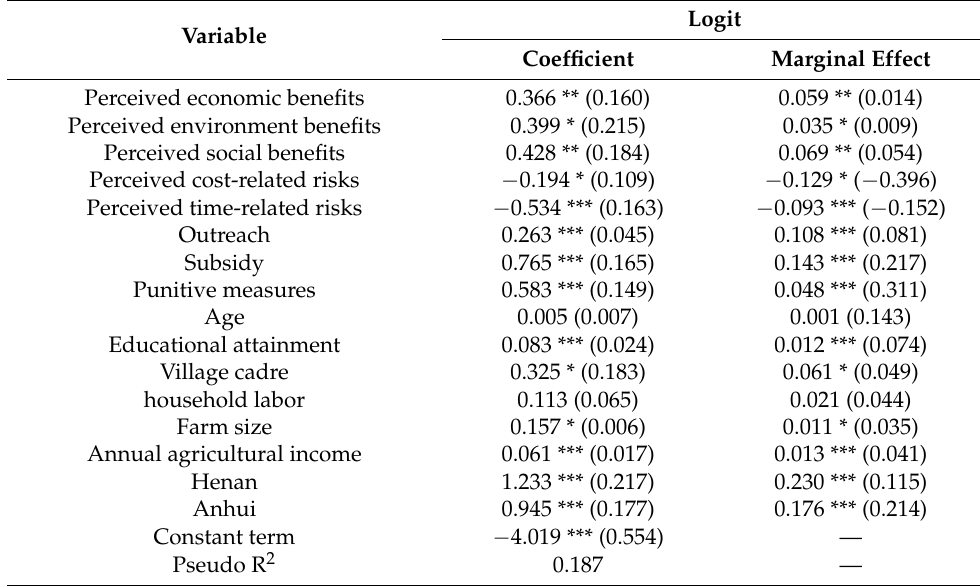
Table 2. The main effect of perceived value and government regulation on